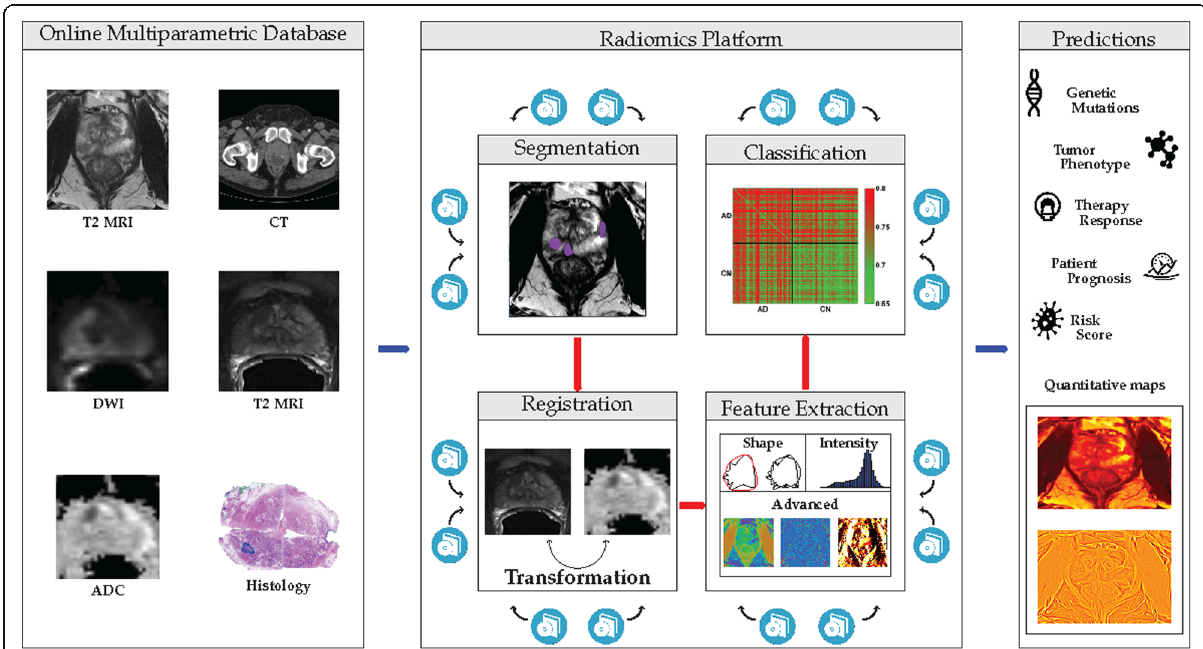
Fig. 10 Radiomics pipeline, with the aim to link imaging features to clinically relevant parameters such as tumour subtype, patient prognosis and therapy outcome prediction (Courtesy Martijn Starmans and Stefan Klein,